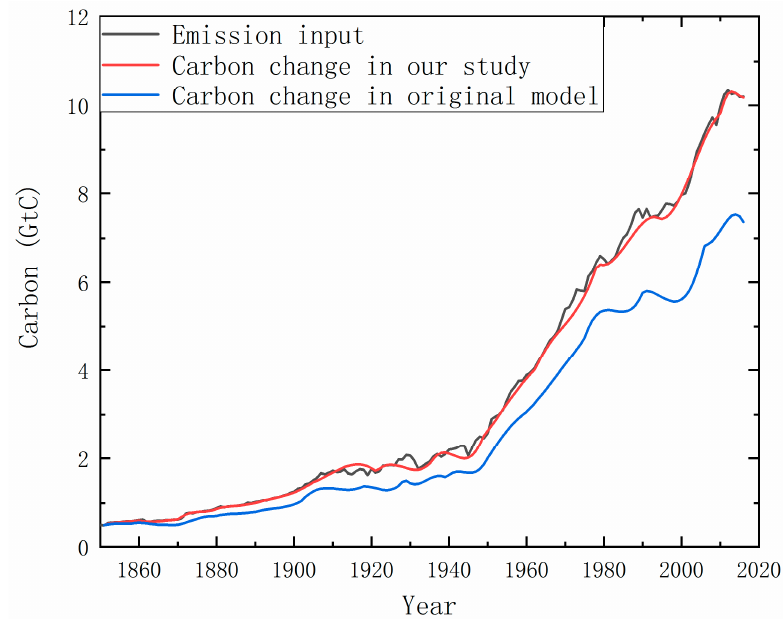
Figure A1. Carbon cycle in the model in our study and original model.